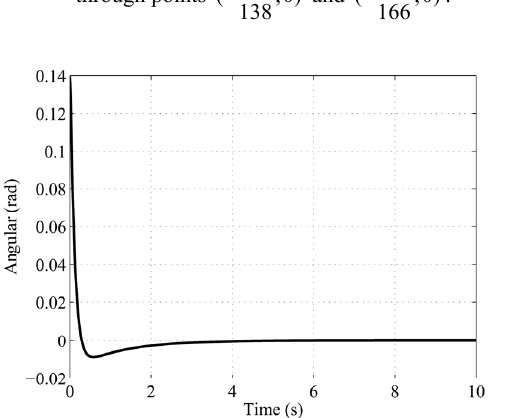
Fig. 9. Nyquist plot of ( ) G j ω and off-axis disk passing through points